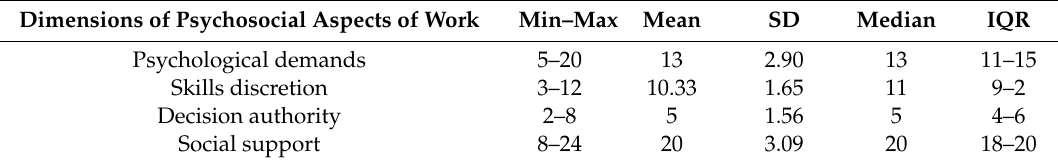
personnel—Brazil, 2012–2013.